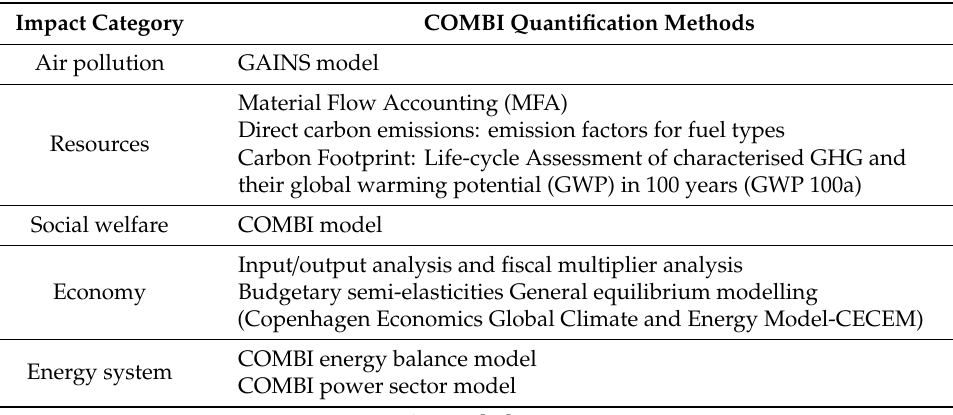
Table 2. Overview of COMBI impact indicators and respective quantification